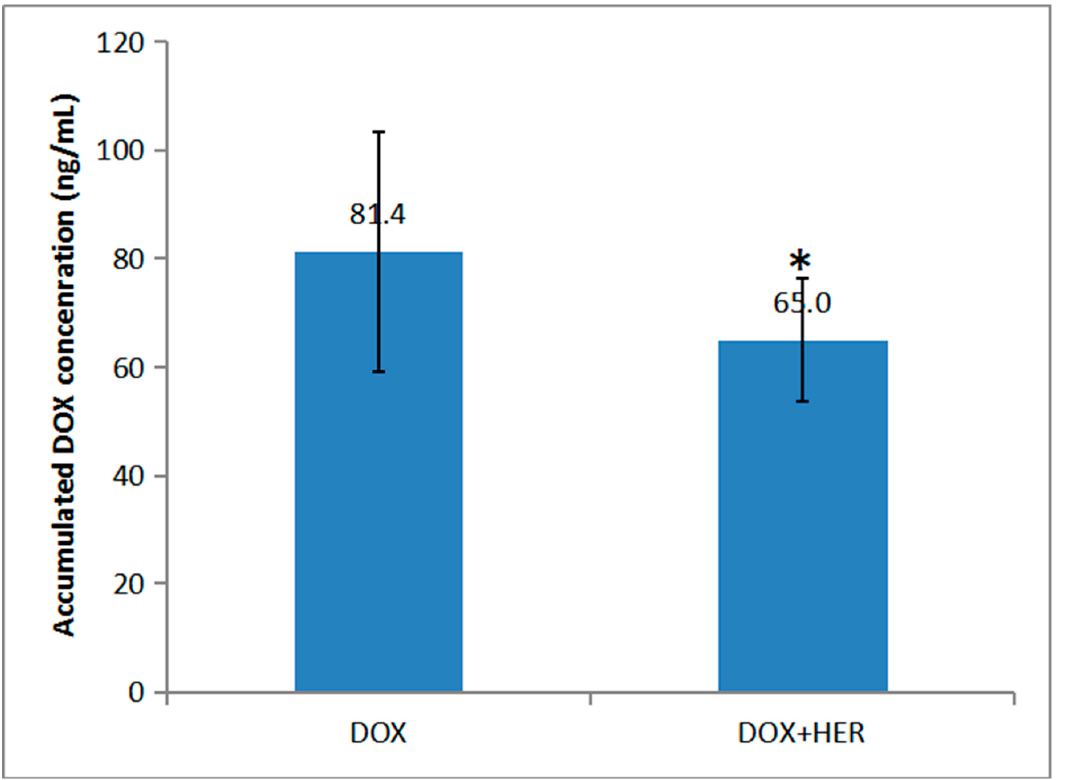
Figure 4. The comparison of the accumulated concentrations of doxorubicin in myocardial tissues 8 h after the intravenous administration of doxorubicin and doxorubicin + hernandezine (mean ± SD, n = 6, p < 0.05).